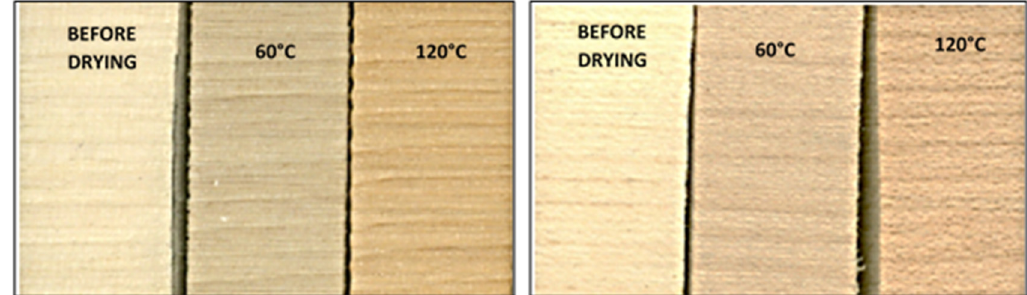
Figure 5. Color change in hornbeam and maple during hot-air drying (60 °C) and high-temperature drying (120 °C).